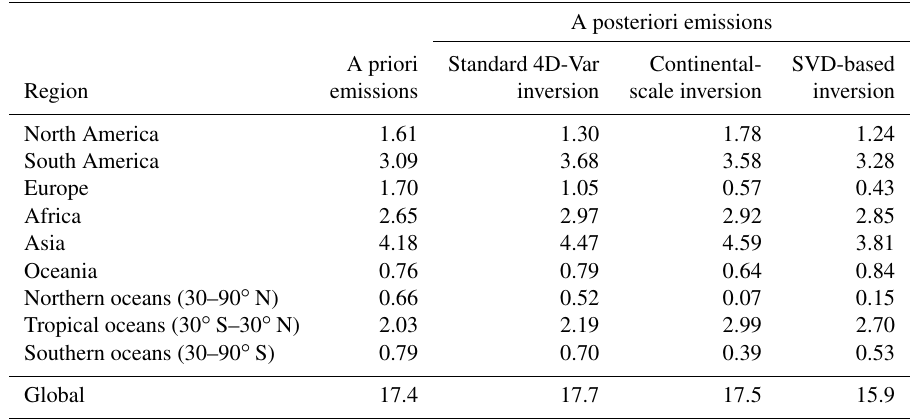
Table 3. 2011 N 2 O emissions (TgNyr − 1 ) over six continental and three oceanic regions for the a priori database and a posteriori results for the three inversion frameworks used